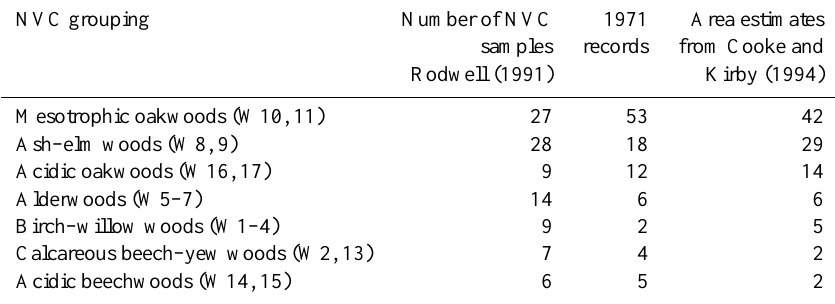
Table 3. Comparison of woodland NVC types identified in 1971 survey data with other estimates across the country. Values expressed as percentages of